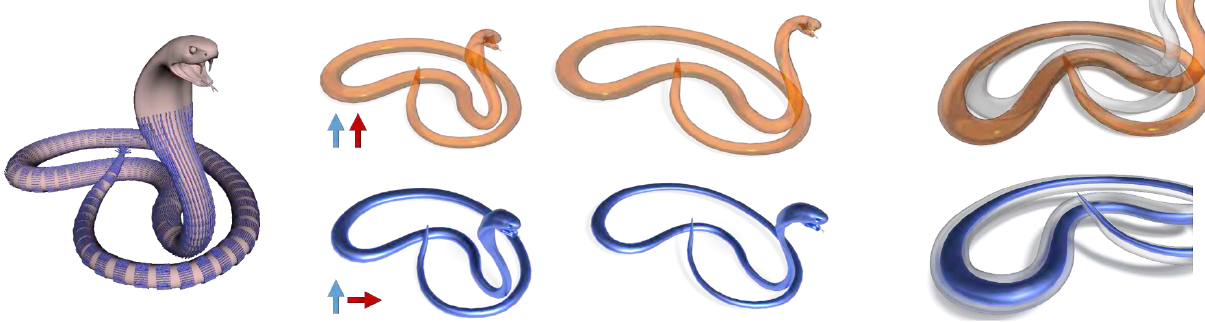
Fig. 8 A curvature-aligned direction field is used to deform the snake. Top: the snake is scaled parallel to the field to elongate it—its thickness is well preserved. Bottom: deformation is performed perpendicular to the field to achieve a thickening—its length is well preserved.